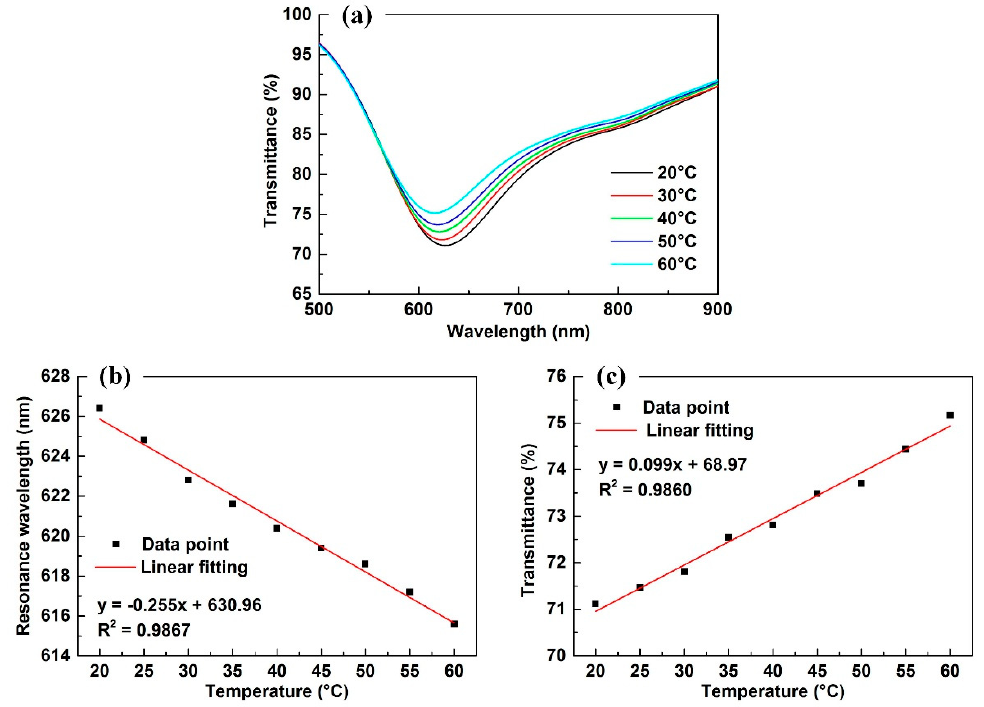
Figure 7. ( a ) The transmitted spectra under a series of temperatures; ( b ) the resonance wavelength as the function of temperature; ( c ) the transmittance as the function of temperature.